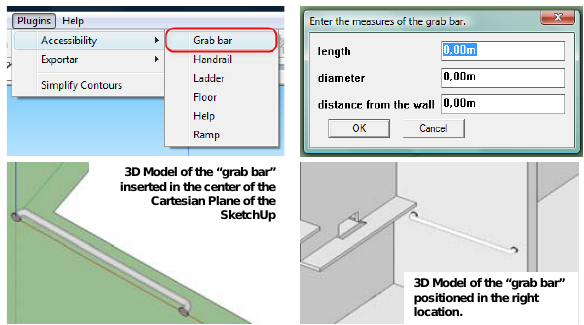
Figure 3. SketchUp_Access selecion menus and equipment insertion